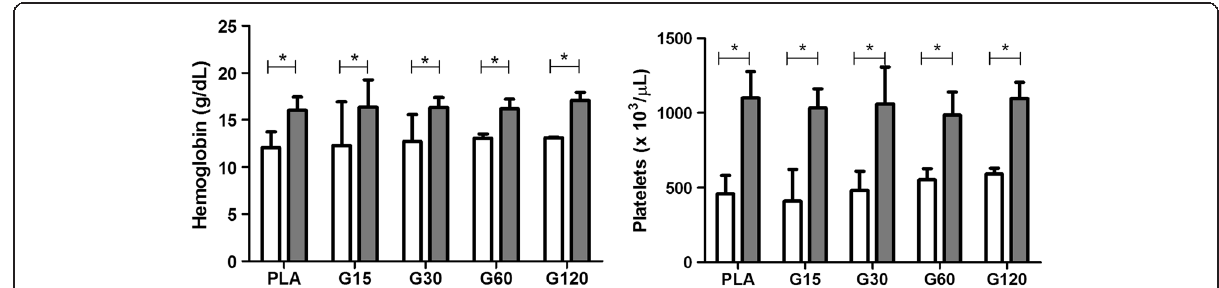
Figure 2 Effects of different doses of MVIIC on hemoglobin (g/dL) and platelets (× 10 3 / μ L). Mean number ± SD of hemoglobin and platelets of rats submitted to compressive spinal cord injury and treated with placebo (PLA, positive control) or ω -conotoxin MVIIC (G15, 15 pmol MVIIC; G30, 30 pmol MVIIC; G60, 60 pmol MVIIC), preoperatively (white column) and eight days after treatment (gray column) (* p < 0.05). Hemoglobin and platelets concentration normal values are, respectively, 13.5-17.4 g/dL and 574 – 1253 × 10 3 / μ L, as described by Giknis and Clifford [39].